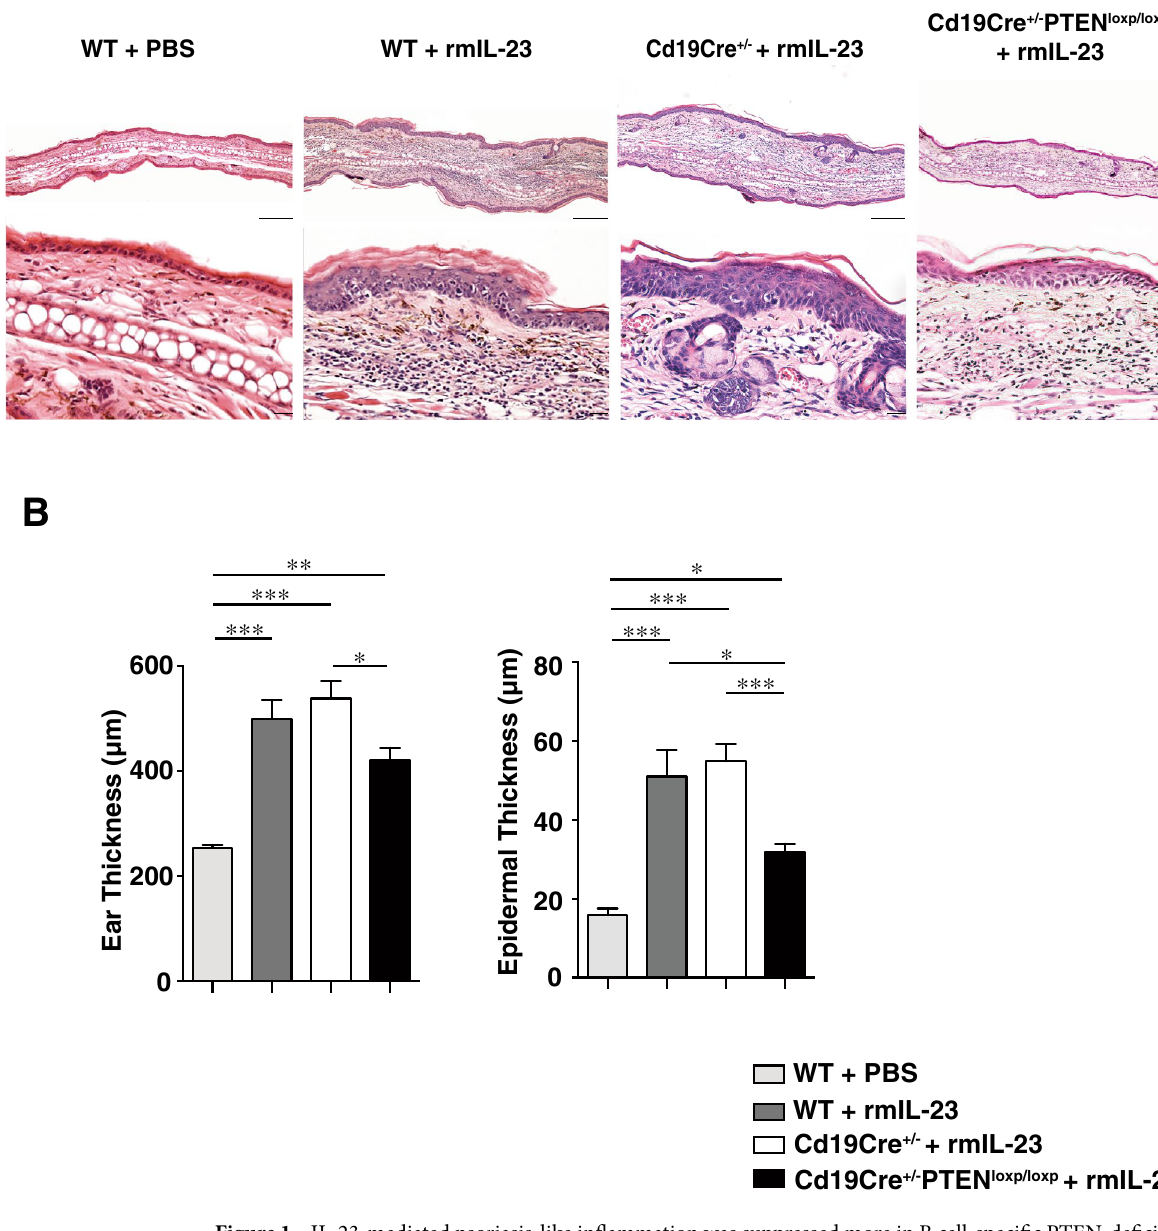
Figure 1. IL-23-mediated psoriasis-like inflammation was suppressed more in B cell-specific PTEN-deficient mice. ( A ) H&E staining of skin section from rmIL-23 or PBS-injected ears in WT mice, Cd19Cre + /− mice and Cd19Cre + /− Pten loxP/loxP mice. rmIL-23 induced hyperkeratosis, parakeratosis, acanthosis, and infiltration of mononuclear cells in the dermis (original magnification × 40, 200; bars = 200 μm and 20 μm). ( B ) Ear thickness and epidermal thickness were measured on day 15 in WT mice, Cd19Cre + /− or Cd19Cre + /− Pten loxP/loxP mice with intradermal injection of 20 μL PBS/0.1% BSA with or without 0.5 μg rmIL-23. Values represent means ± SEMs. Significant differences between sample means are indicated as: * P < 0.05, ** P < 0.01, *** P < Fig. 4C). rmIL-23 injection significantly increased the frequencies of CD25 hi FoxP3 + CD4 + Tregs in the drain- ing lymph nodes during the course of disease progression in Cd19Cre + /− Pten loxP/loxP mice ( P < 0.05 and P < 0.01; Fig. 4D). The frequencies of CD25 hi FoxP3 + CD4 + Tregs in the draining lymph nodes was also significantly increased in Cd19Cre + /− Pten loxP/loxP mice compared to those in Cd19Cre + /− mice on day15 ( P < 0.01; Fig. 4D). rmIL-23 injection significantly increased the number of CD25 hi FoxP3 + CD4 + Tregs in the draining lymph nodes in both groups on day 7 ( P < 0.05; Fig. 4D). Our data thus suggests that Bregs in the spleen were significantly expanded in rmIL-23-injected B cell-specific PTEN-deficient mice and expanded significantly on day 7 and con- tracted on day15 while keeping high levels. On the other hands, Tregs in the spleen and draining lymph nodes